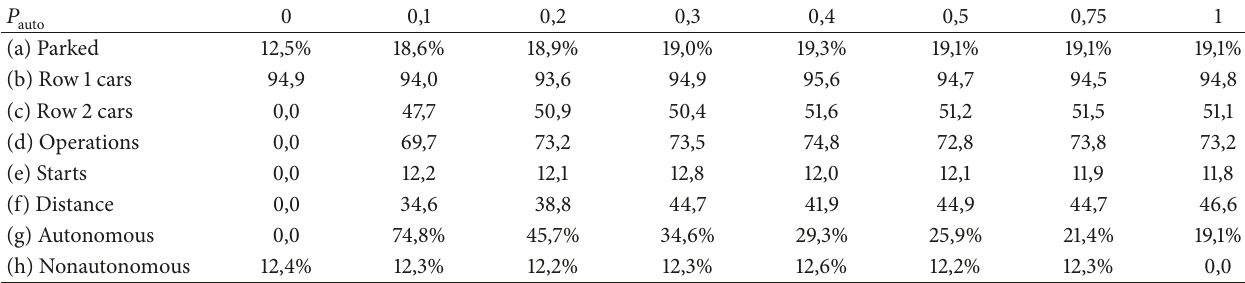
Table 3: Results, second scenario, 765